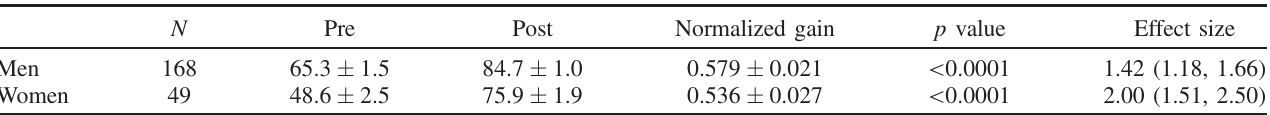
TABLE II. Force Concept Inventory data for men and women. Pre- and postscores and normalized gains are reported (cid:2) the standard error of the mean. The 95% confidence interval (C.I.) on the effect is shown in the effect size. N Pre Post